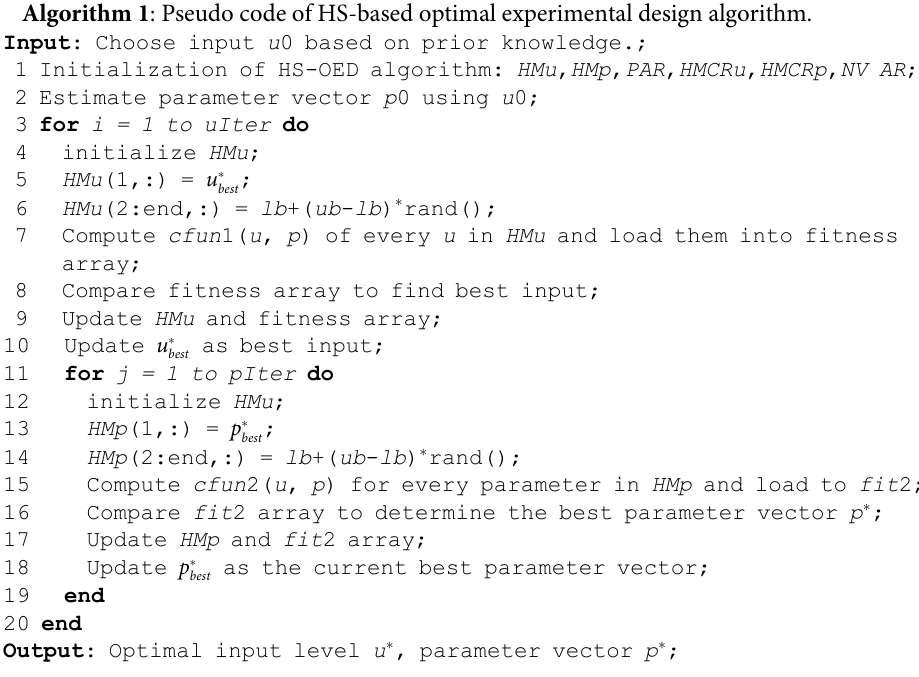
Algorithm 1 : Pseudo code of HS-based optimal experimental design